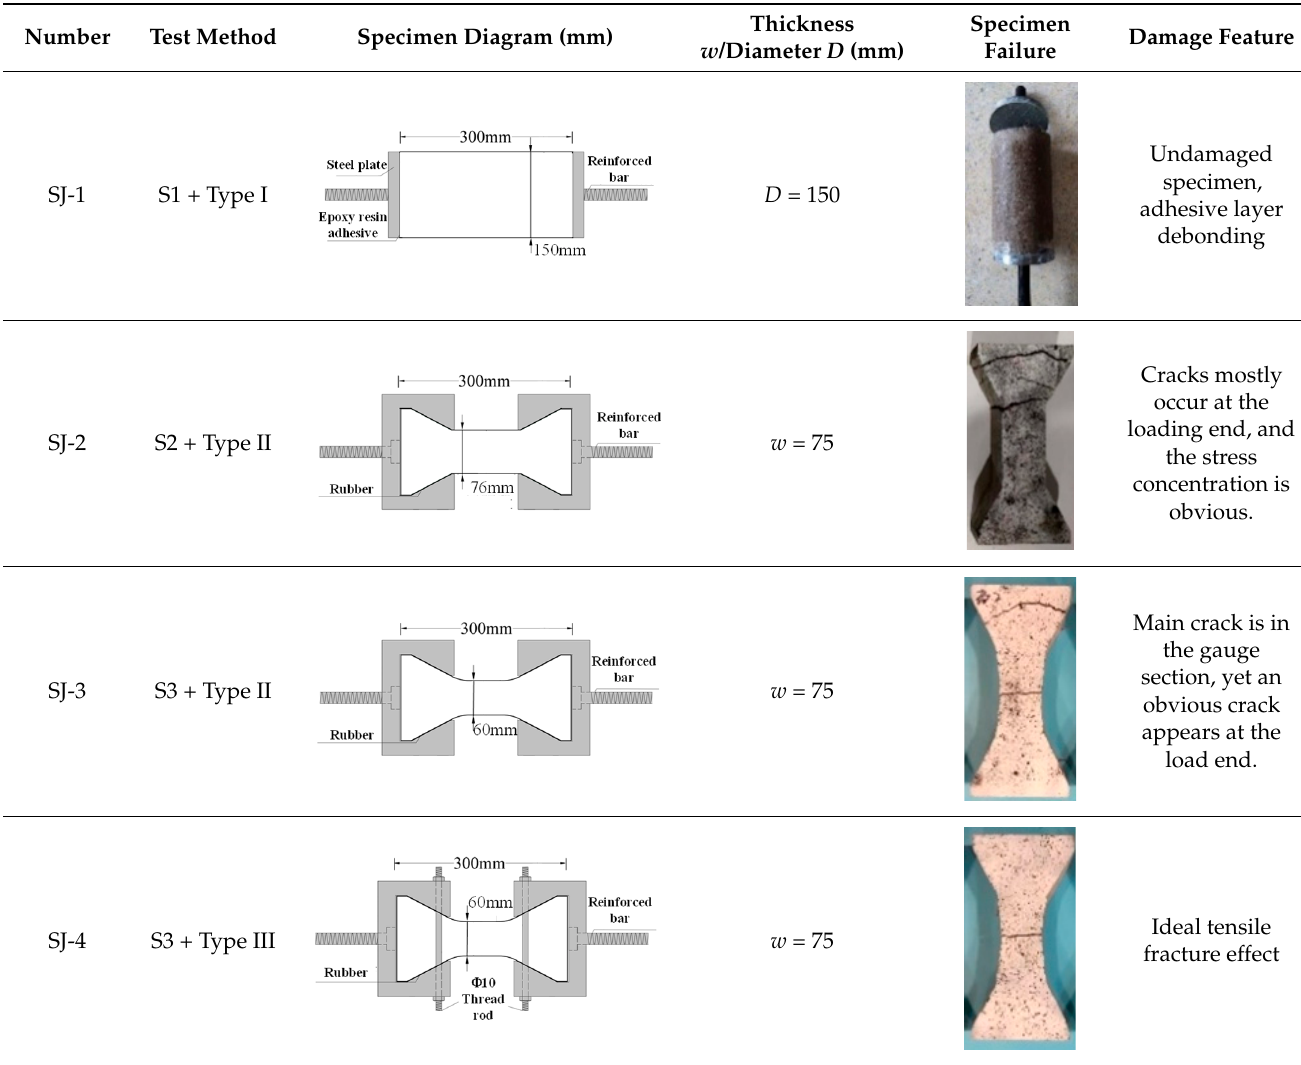
Table 3. Comparison of MPUC contact stretching schemes.